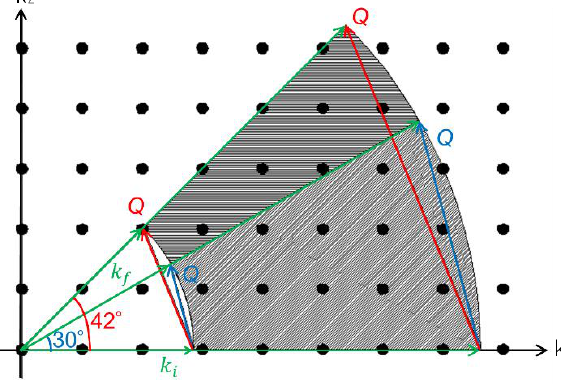
Figure 6. Reciprocal space map.